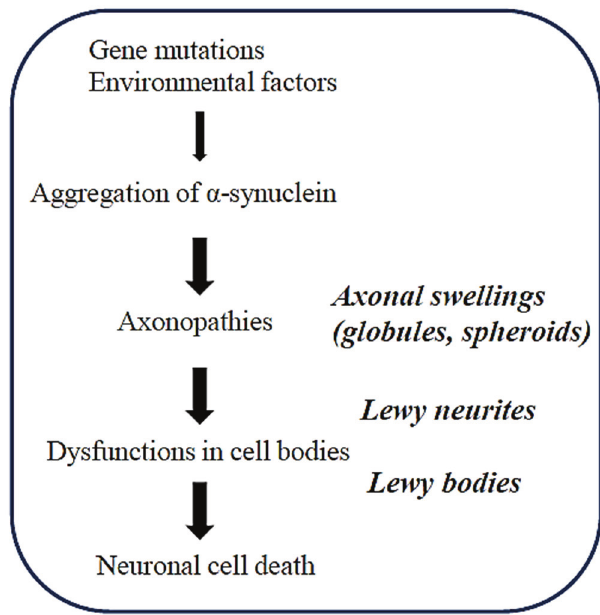
Figure 1. A hypothetical sequence of the pathogenesis of (cid:2)-synucleinopathies. Axonopathies may precede the pathology of neuronal cell bodies in neurodegeneration. Various morphological changes (e.g., axonal swellings, Lewy neuritis and Lewy bodies) are associated with the progress of the